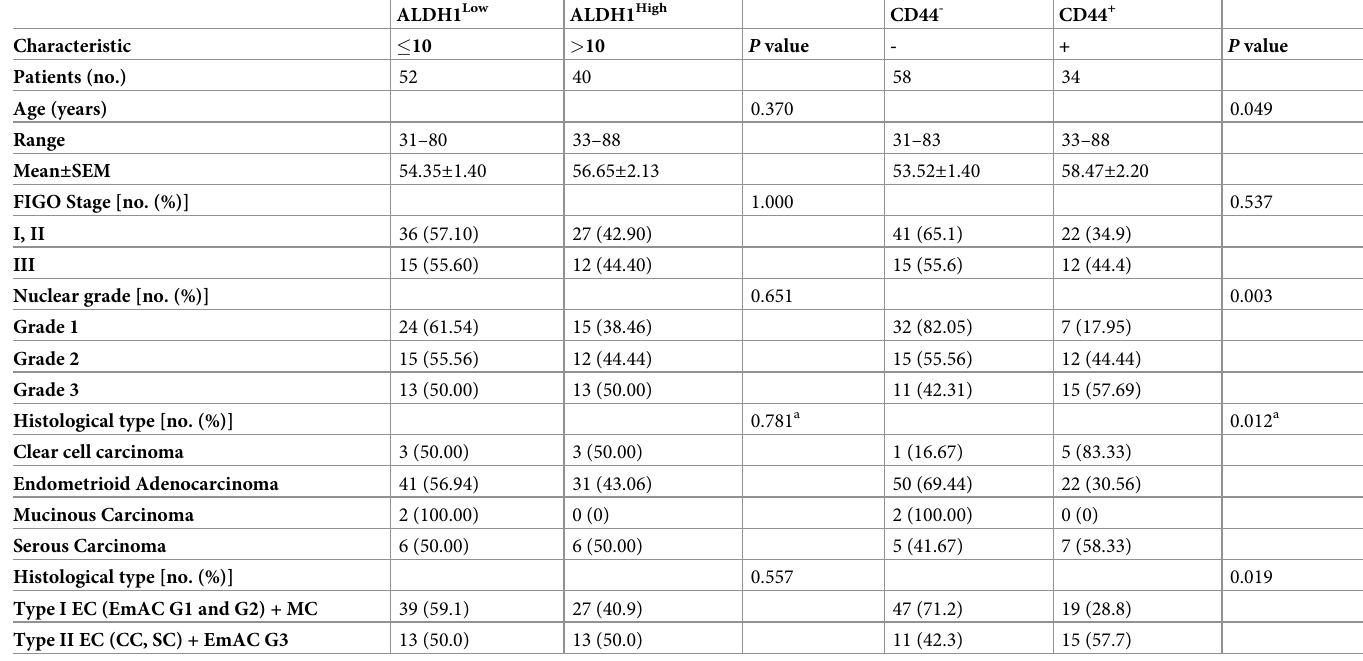
Table 2. Correlation of ALDH1 and CD44 expression score with clinicopathological features in endometrial carcinoma. ALDH1 Low ALDH1